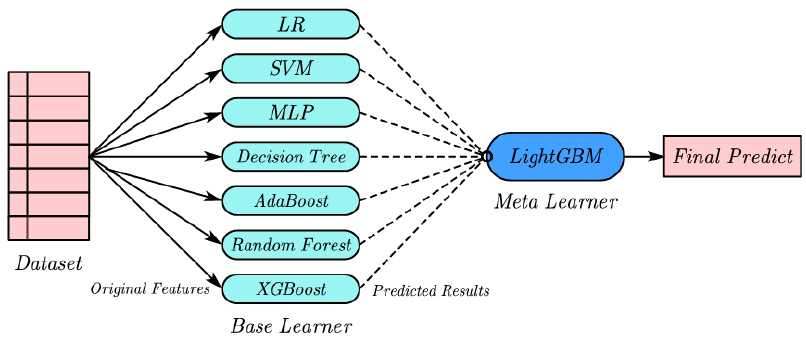
Figure 3. Diagram of the stacking fusion model structure.